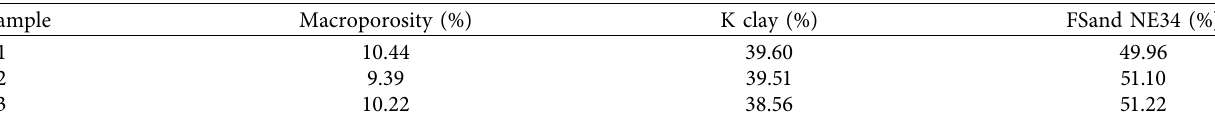
Table 3: Comparison of the volume fractions (%) of the three